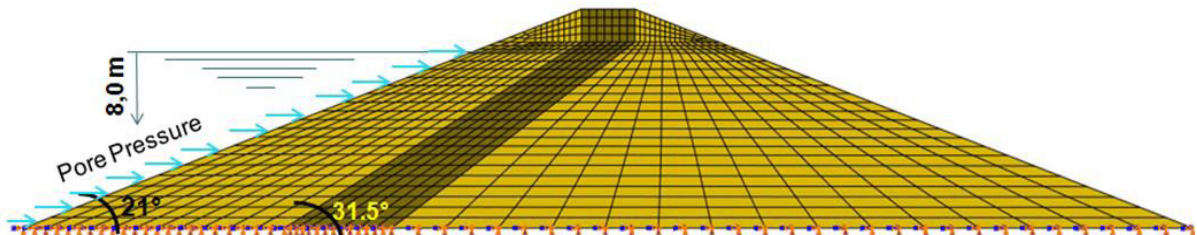
Figure 2: Model geometry and finite element mesh of the embankment with sloping core